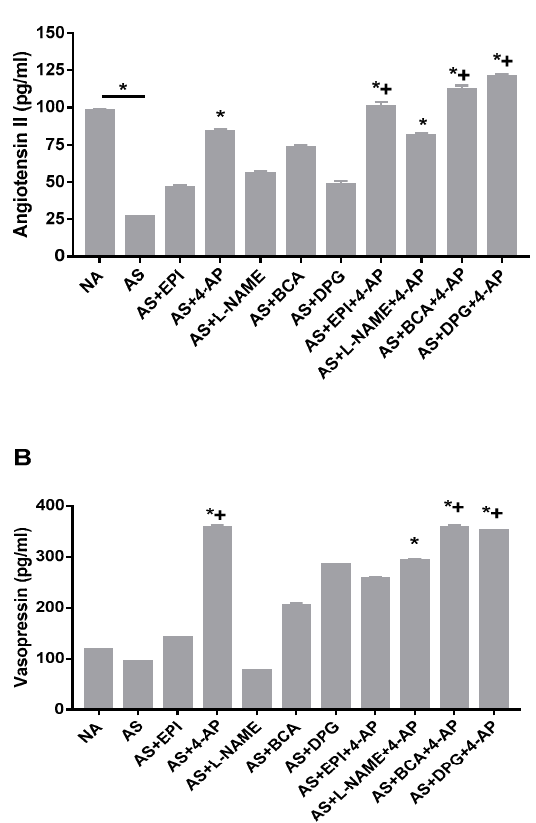
Figure 6. Arterial plasma concentrations of angiotensin II ( A ) and vasopressin ( B ) after OVA injection in non-allergic (NA) or allergic rats (AS) treated with EPI, L-NAME, DPG, BCA, 4-AP or EPI, and in rats treated with the 4-AP drug combinations L-NAME+4-AP, DPG+4-AP, BCA+4-AP, or EPI+4-AP. Values are Mean ± S.E.M; * p < 0.05 vs. AS group; + p < 0.05 vs. EPI group; ≠ p < 0.05 vs. 4-AP group. NA, non-allergic rats; AS, allergic rats; BCA, β -cyanoalanine; DPG, dl-propargylglycine; L-NAME, L-NG-Nitroarginine methyl ester; 4-AP, 4-aminopyridine; EPI, epinephrine. BCA+4-AP, β -cyanoalanine+4-aminopyridine; DPG+4-AP, dl-propargylglycine+4-aminopyridine; L-NAME+4-AP, L-NG-Nitroarginine methyl ester+4-aminopyridine; EPI+4-AP, epinephrine+4-aminopyridine.